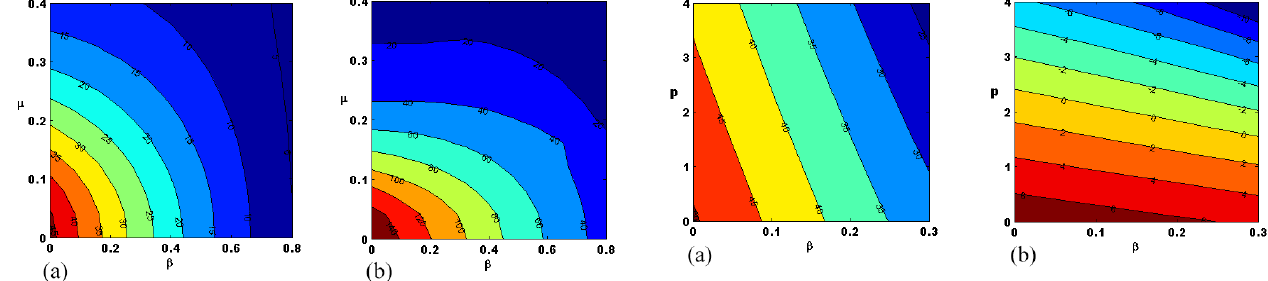
Figure 4. Contour plot of q 2 with respect to β and µ , (a) SS, (b) CS.